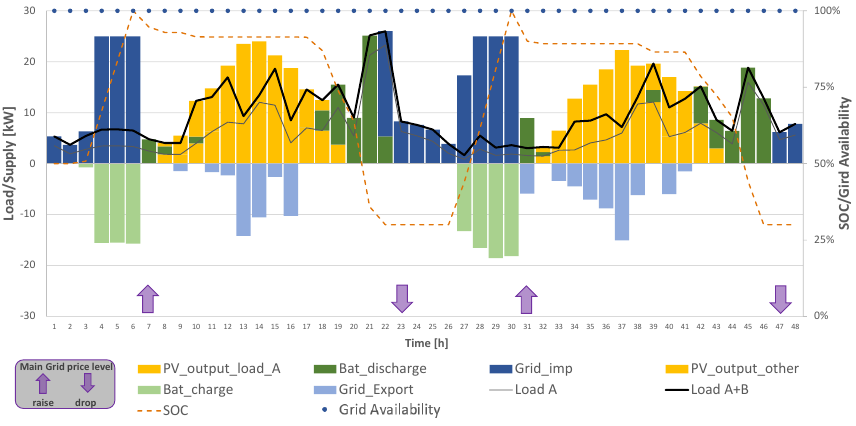
Figure 7. UMG optimal dispatch for dry season and full